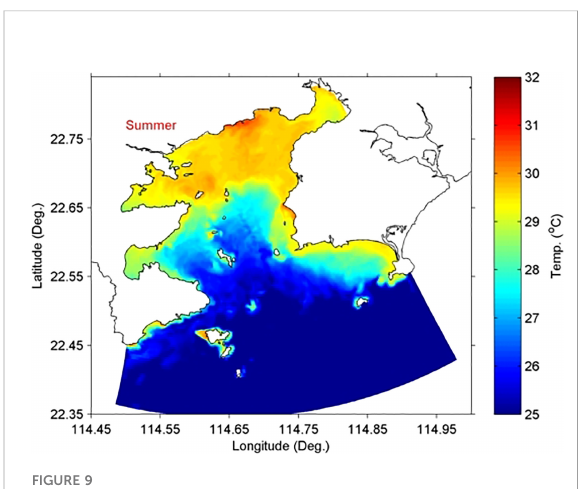
FIGURE 7 Same as Figure 7, but for the tidal currents during ebb tide period.